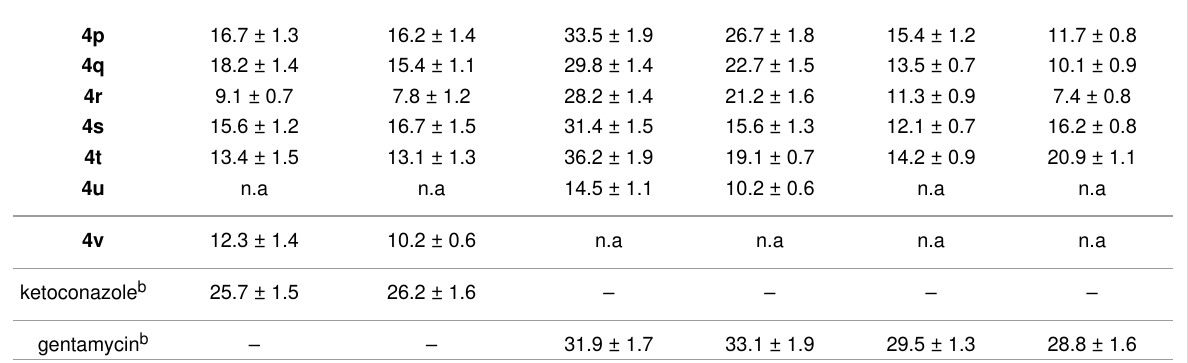
Table 1: In vitro antimicrobial activities of the synthesized compounds tested at 10 mg/mL by modified well diffusion agar method and expressed as mean inhibition zone diameter (mm). (continued)